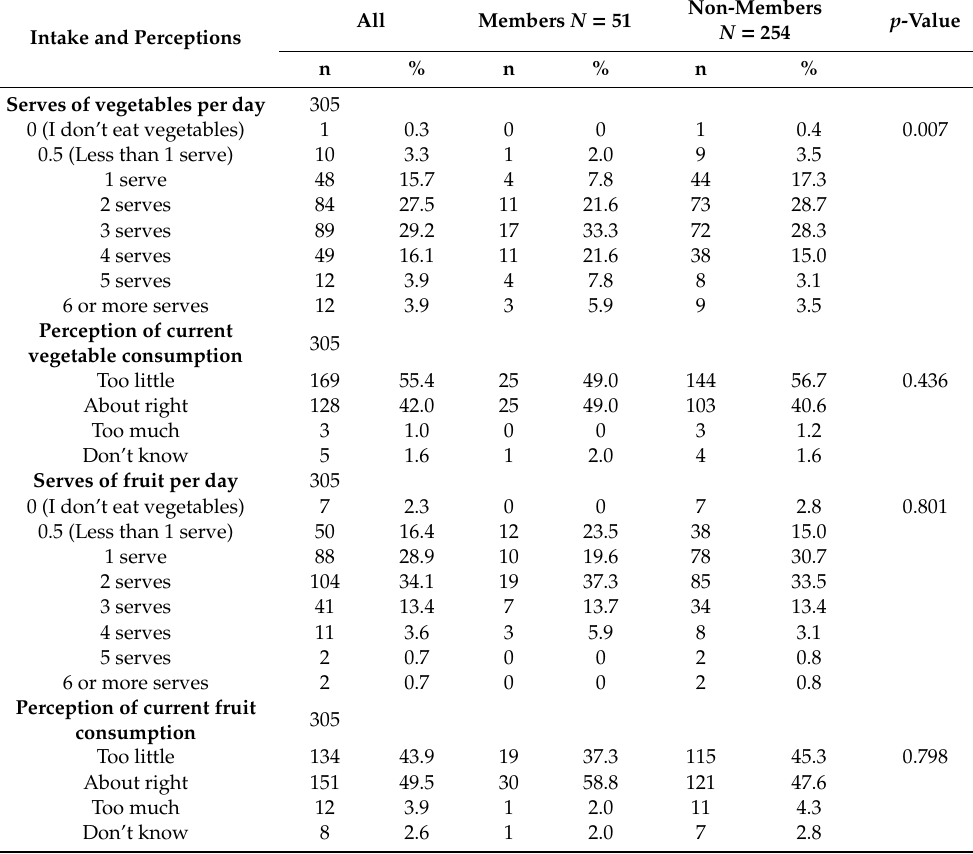
Table 3. Participant fruit and vegetable intake and related perceptions by fruit and vegetable co-op